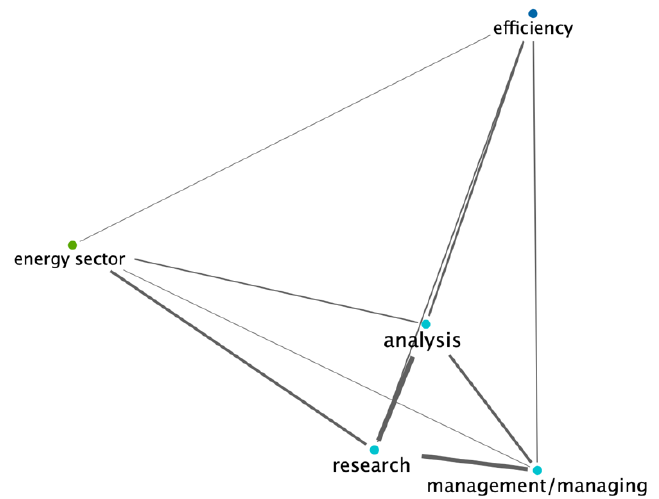
Figure 3. Code map (node size by number of occurrences). Source: own study.